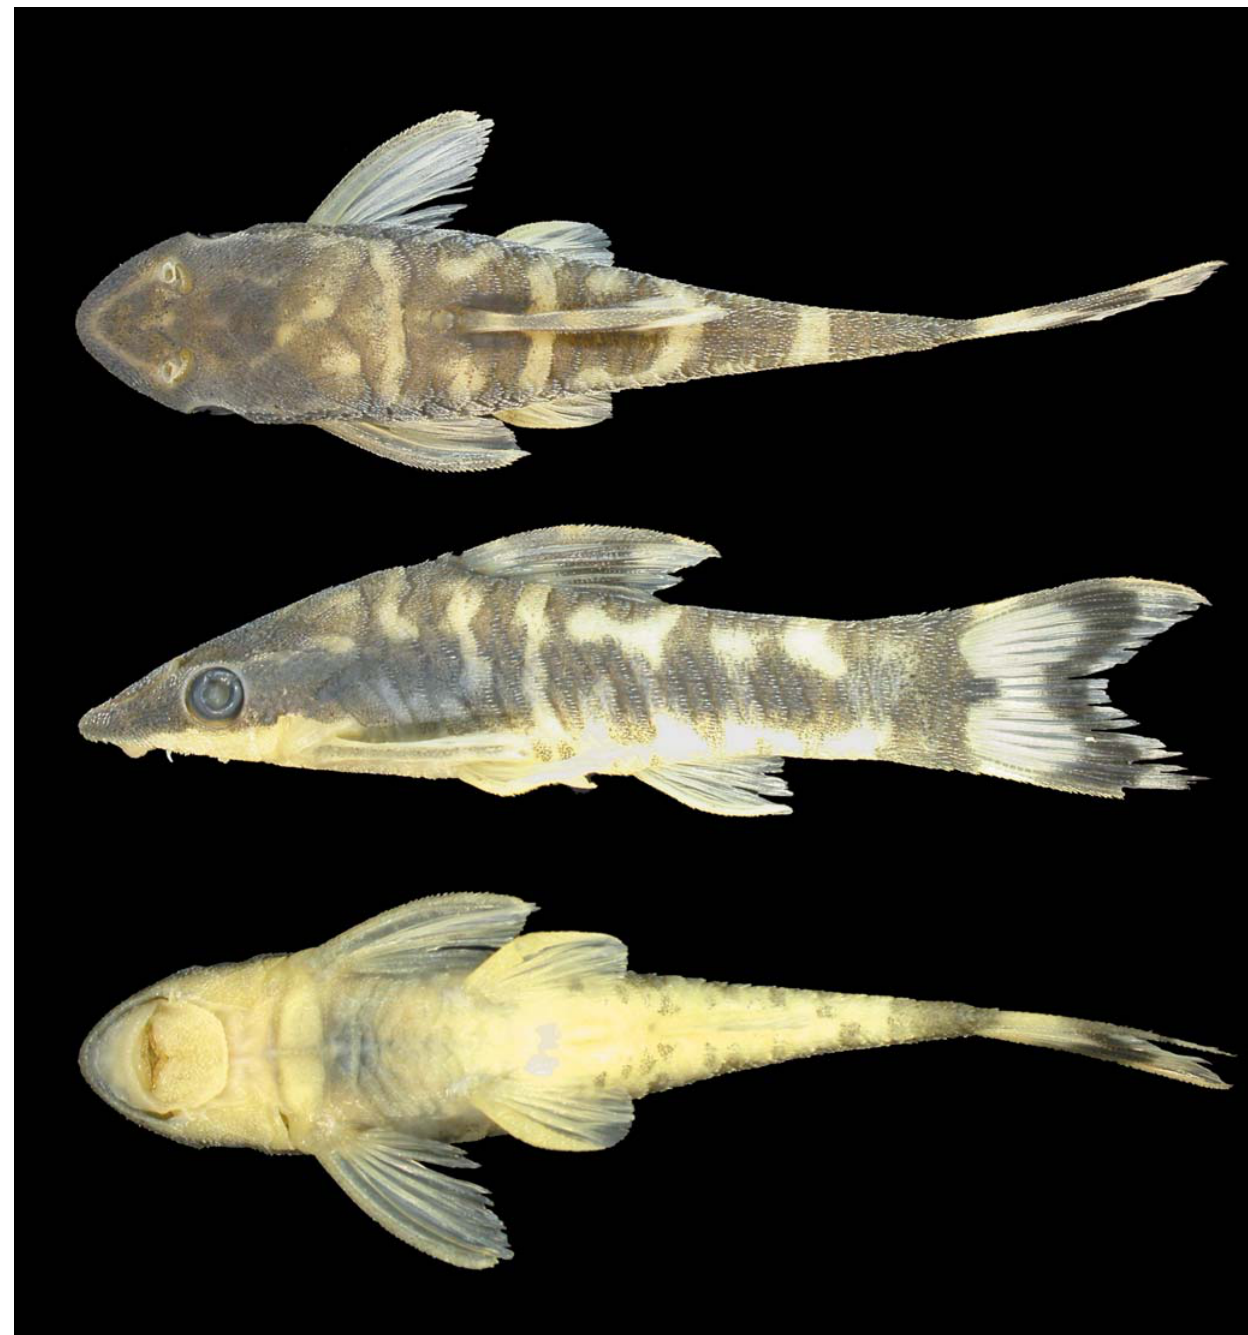
Fig. 1. Otocinclus cocama , holotype, MUSM 20686, 43.5 mm SL, female, quebrada Yanayacu, Jenaro Herrera, Loreto, Peru. roundish, covered with small papillae; margin of lower lip heavily fringed; maxillary barbel short, its free portion about one fourth to one third of orbit length. Color in life . Ground color of head and dorsum bluish white to slightly creamy yellowish. Dorsum of head and snout between nares black. Lateral portions of snout and postorbital region of head also black, leaving narrow, V-shaped white band beginning at snout tip, passing through nares and above orbits, and